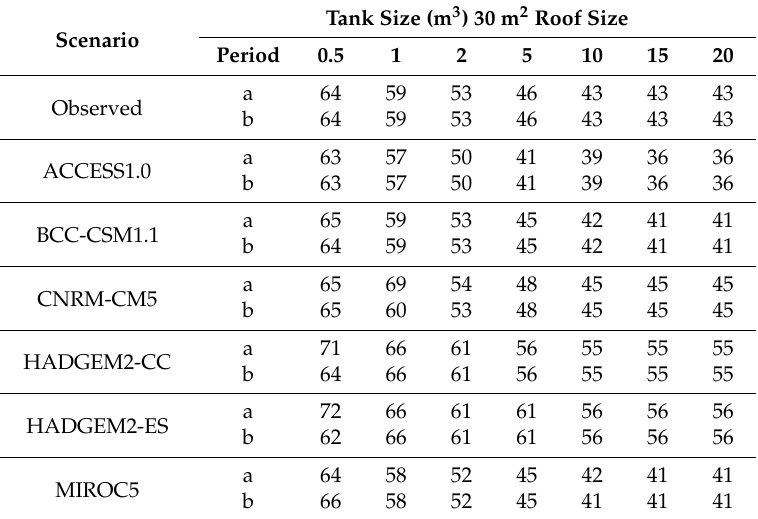
Table 9. Observed and projected water security for DJF dry